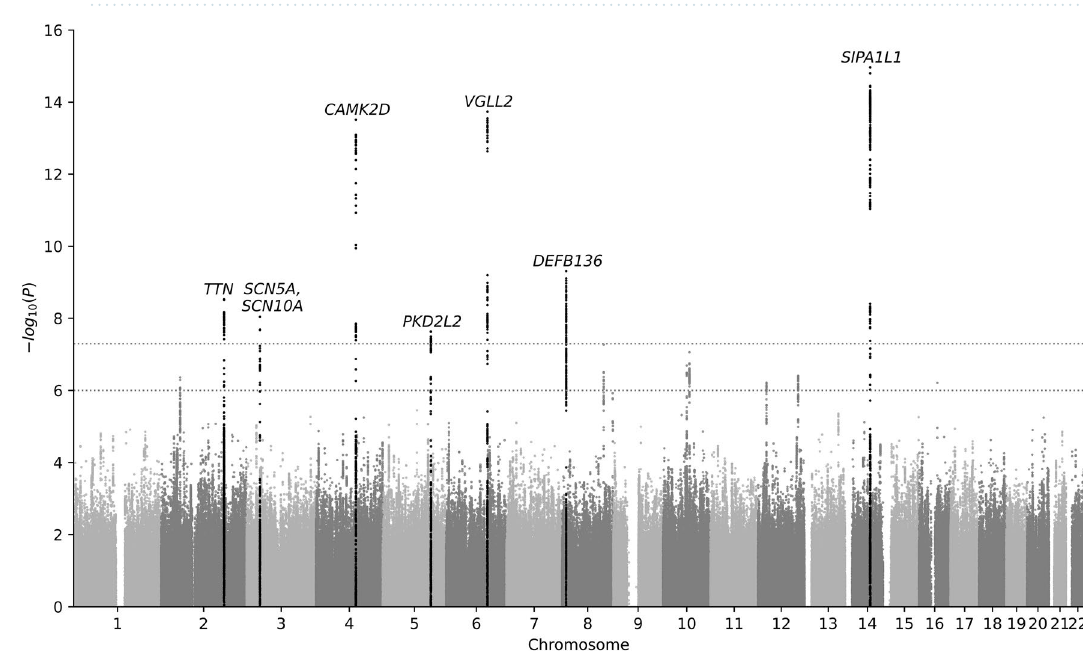
Figure 2. Manhattan plot. Association tests (n=34,432) were adjusted for age, sex, genotyping array, and UKB assessment centre. Horizontal lines mark the thresholds of genome-wide and suggestive significance 8 6 ( p ≤ 5 × 10 − and p ≤ 1 × 10 − ,